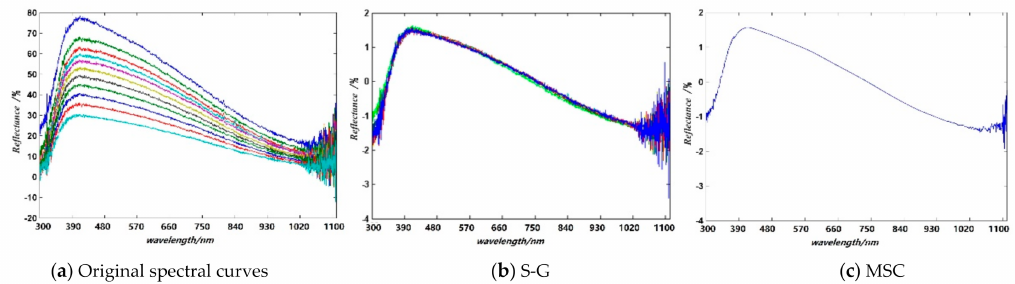
Figure 3. Some spectral curves of the ceramic from one